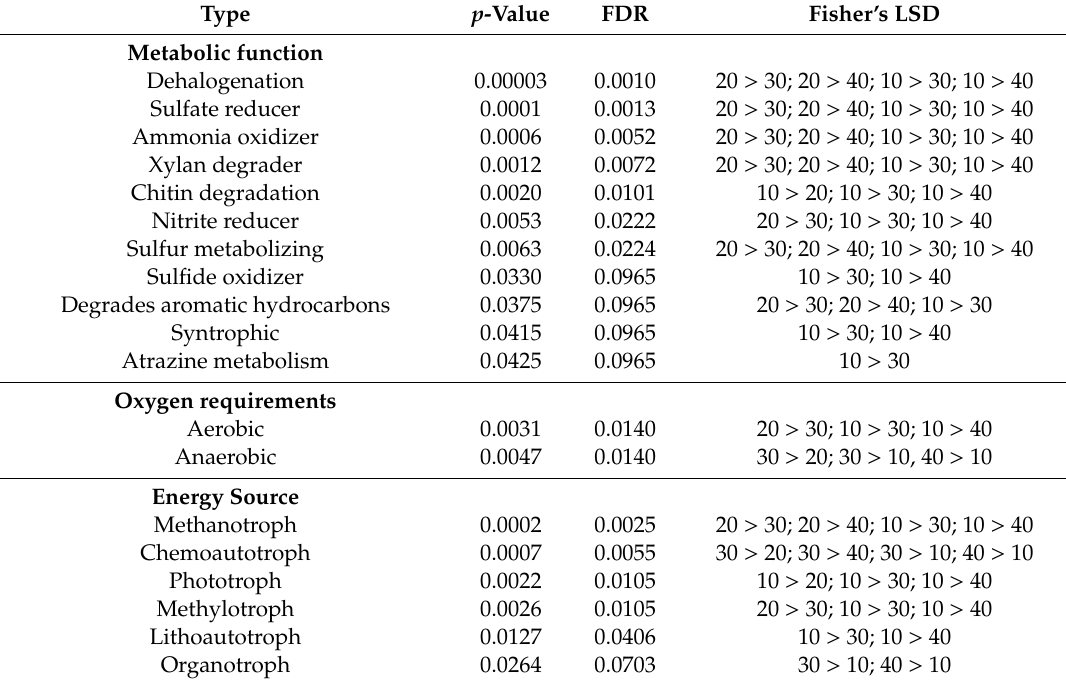
Table 5. Summary of predicted phenotypic classification based on core depth bacterial 16S sequencing data from Moreton Bay marine sediment using one-way ANOVA